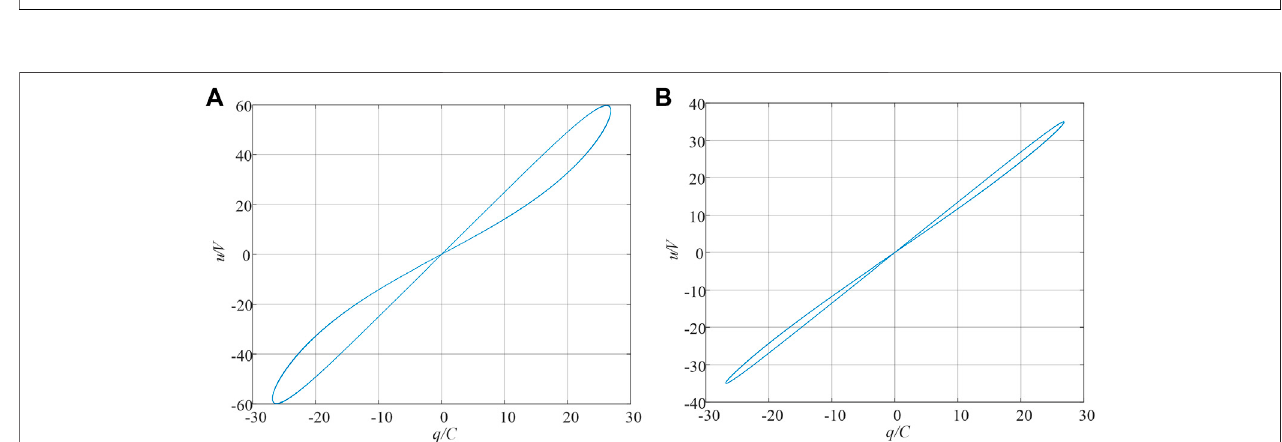
FIGURE 1 | v - i curve of the memristor with b = 2.6, a = 2 (A) f = 10 Hz. (B) f = 50 Hz.